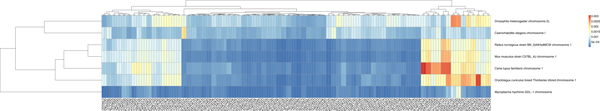
The CCGGAT-spectrum set. This tree perfectly resembles the taxonomy tree of Figure 14 and shows the great evolutionary distances between the organisms. The rat and mouse are found to be closely related. We note tree distinct subtrees: one containing the bacterium, one for the mammals and one containing the worm and fruit fly. The location of these subtrees conforms to taxonomy tree.